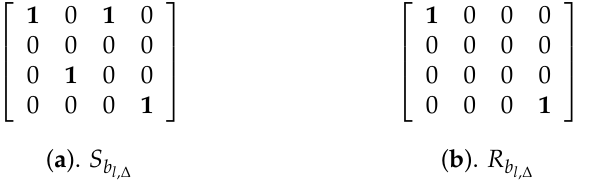
) , where P = = E ( S 4 b l , ∆ l , ∆